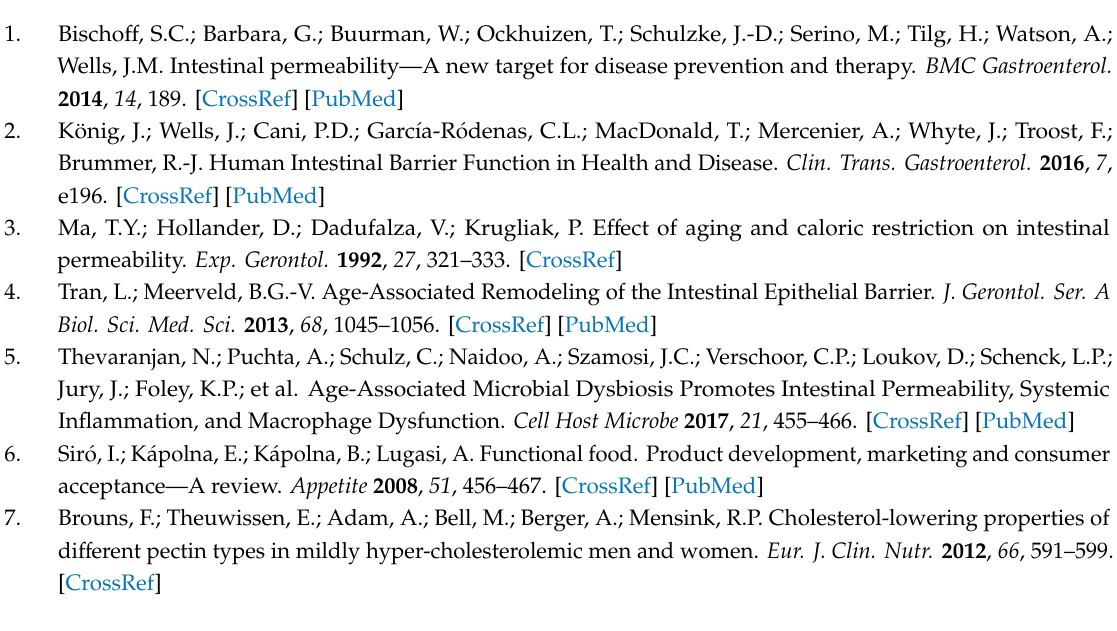
Figure S1: Mucosal defense parameters at baseline and after four weeks of pectin (circles) or placebo (triangles) intervention in young adults and elderly. A : Salivary sIgA1 (g / mL) in young adults. B : Salivary sIgA1 (g / mL) in elderly. C : Salivary sIgA2 (g / mL) in young adults. D : Salivary sIgA2 (g / mL) in elderly. E : Serum IgA1 (g / mL) in young adults. F : Serum IgA1 (g / mL) in elderly. G : Serum IgA2 (g / mL) in young adults. H : Serum IgA2 (g / mL) in elderly. I : Fecal sIgA (g / L) in young adults. J : Fecal sIgA (g / L) in elderly. Values are presented in scatter plots with median line and IQR (25–75th interquartile range). Sample sizes vary due to drop-outs and technical reasons. Within age groups, mucosal defense parameters were compared between intervention groups with unstructured linear mixed models and correction for baseline values. IgA, Immunoglobulin A; sIgA, secretory Immunoglobulin A, Figure S2: Gastrointestinal symptoms at baseline and every week of pectin (fixed lines) and placebo (dashed lines) intervention in young adults. A : Abdominal pain scores. B : Constipation scores. C : Diarrhea scores. D : Indigestion scores. E : Reflux scores. Means and standard deviations are shown. Missing values at specific weeks were due to drop-outs. Gastrointestinal symptom scores were compared between intervention groups with random intercept linear mixed models and correction for baseline values. p -values per time point were corrected for multiple testing by calculating the false-discovery-rate (FDR) of Benjamini-Hochberg, Figure S3: Gastrointestinal symptoms at baseline and every week of pectin (fixed lines) and placebo (dashed lines) intervention in elderly. A : Abdominal pain scores. B : Constipation scores. C : Diarrhea scores. D : Indigestion scores. E : Reflux scores. Means and standard deviations are shown. Gastrointestinal symptom scores were compared between intervention groups with random intercept linear mixed models and correction for baseline values. p -values per time point were corrected for multiple testing by calculating the false-discovery-rate (FDR) of Benjamini-Hochberg, Figure S4: Representative images of tight junction protein TJP1 (green) immunofluorescence staining in sigmoid biopsy sections of a healthy young adult and healthy elderly after four weeks pectin or placebo intervention. Scale bar represents 100 µ m. Blue counterstaining (DAPI) shows nuclei. TJP1: Tight junction protein 1, Figure S5: Representative images of tight junction protein occludin (red) immunofluorescence staining in sigmoid biopsy sections of a healthy young adult and healthy elderly after four weeks pectin or placebo intervention. Scale bar represents 100 µ m. Blue counterstaining (DAPI) shows nuclei, Table S1: Forward and reverse primer sequences and final cDNA concentrations of all target genes, as determined in sigmoid biopsies, Table S2: Baseline characteristics of the subgroups of young adults ( n = 22) and elderly ( n = 22), undergoing sigmoidoscopy after the pectin or placebo